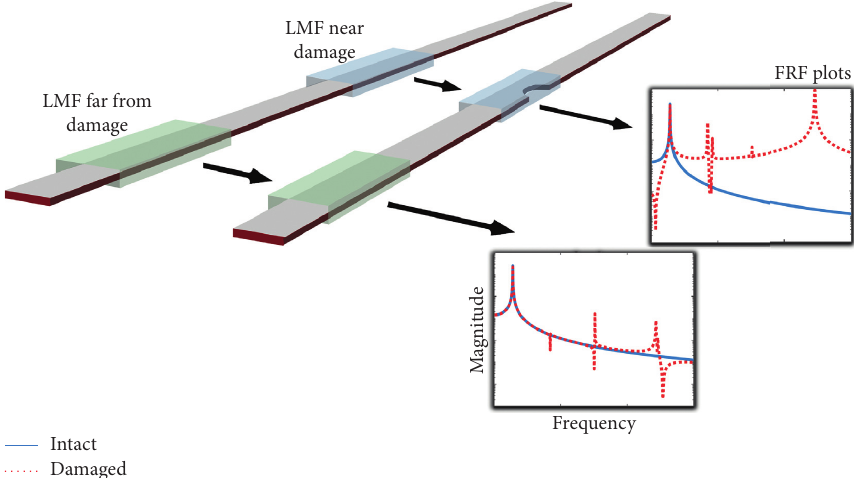
Figure 1: Scheme of localization procedure based on modal filtration.